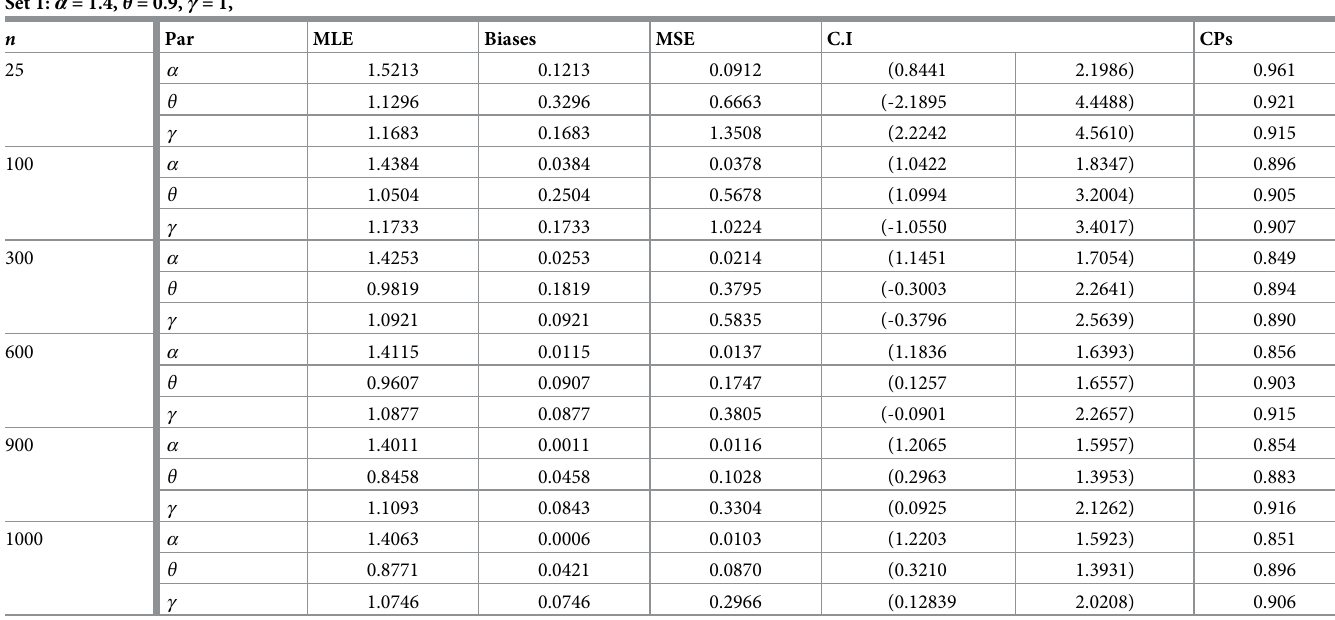
Table 4. Simulation results for different combination of the parameters of TI-HTW